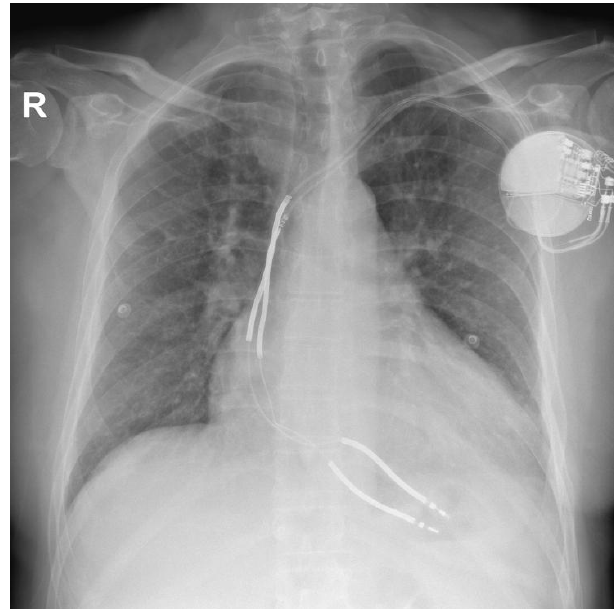
Figure 2. Chest X-ray at the time of admission at the hospital.